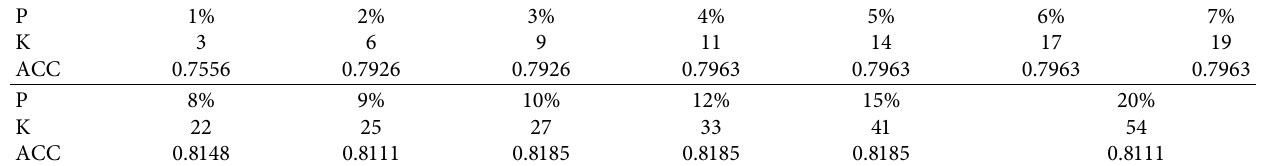
Table 9: Clustering results of the Heart dataset with different K values.